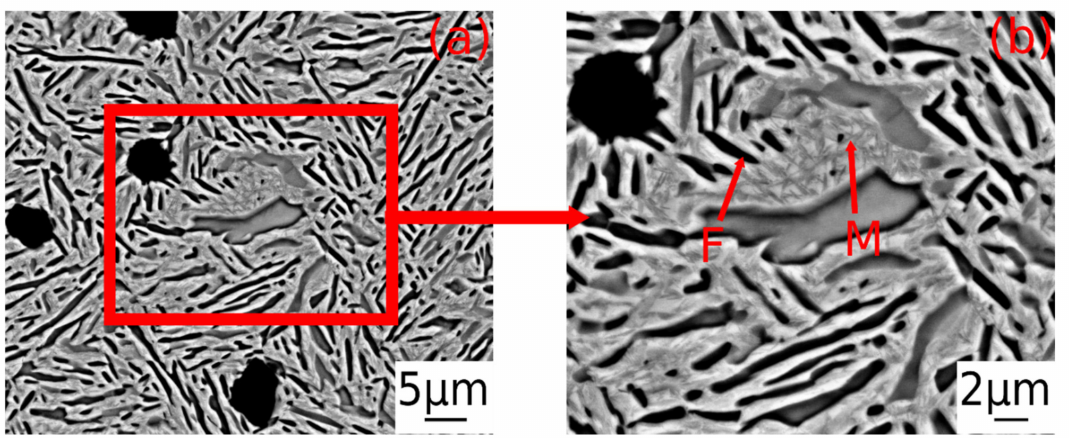
Figure 9. ( a ) Backscattered electrons FEG-SEM image of specimen subjected to Austempering ( b ) lath martensite detail.